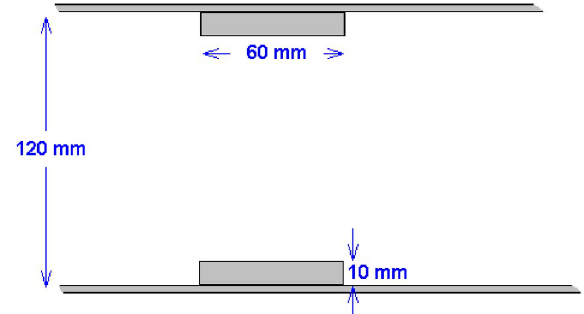
FIG. 10. (Color) Example of antigrazing ring placed in a section of RHIC beam